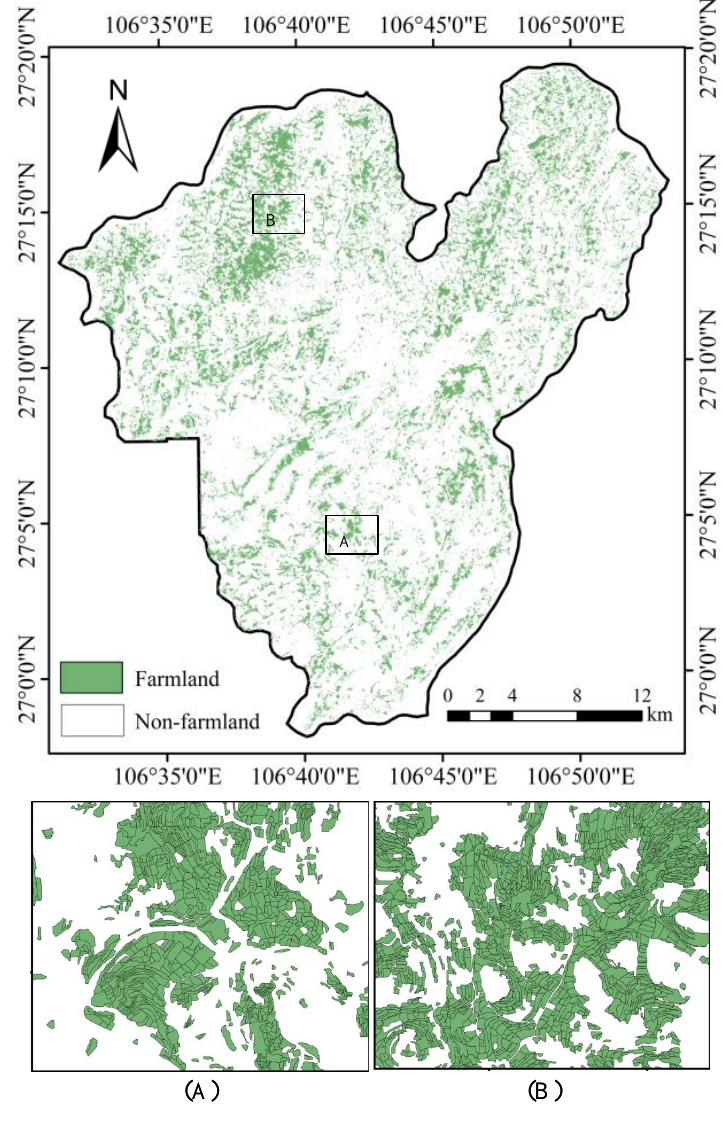
Figure 5. The distribution map of farmland parcels in the study area using the proposed method. ( A , B ) are sub-regions of the study